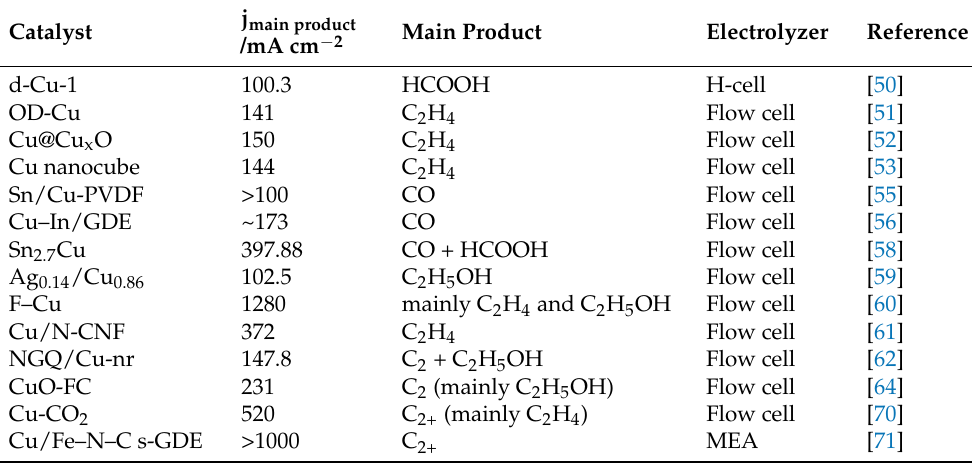
Table 3. CO 2 electroreduction performances of Cu-based